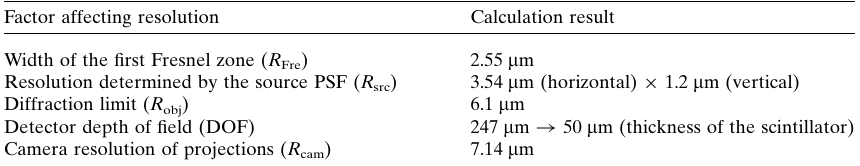
Table 4 Calculation results of the factors affecting resolution in SRX imaging experiments at BSRF 4W1A beamline.